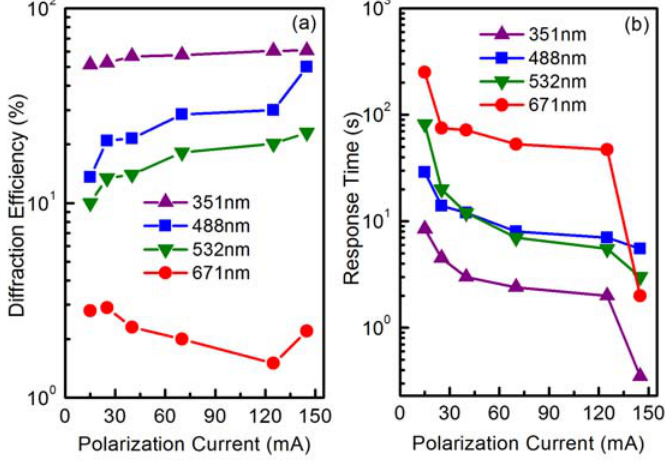
Figure 7. The UV-visible photorefractive characteristics of LN:Mo0.5 crystals polarized under various polarization currents for 15 min. The light intensity per beam is 320, 400, 400 and 3000 mW/cm 2 for 351, 488, 532 and 671 nm lasers, respectively [88].